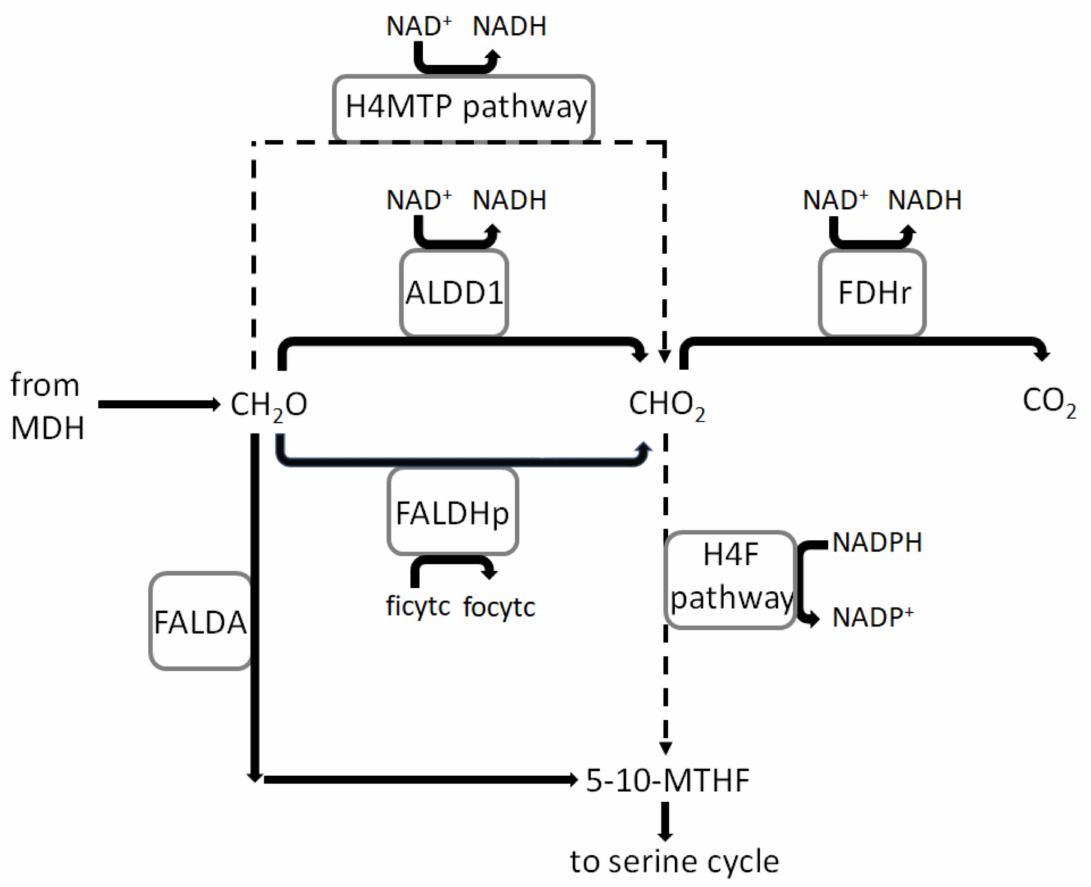
Figure 4. Formaldehyde and formate oxidation and assimilation pathways as implemented in iMsOB3b. The continuous lines represent a single reaction, while the dashed lines represent a series of reaction. ALDD1referstonon-specificaldehydedehydrogenase, FALDHpreferstoformaldehydedehydrogenase, 5-10-MTHF refers to